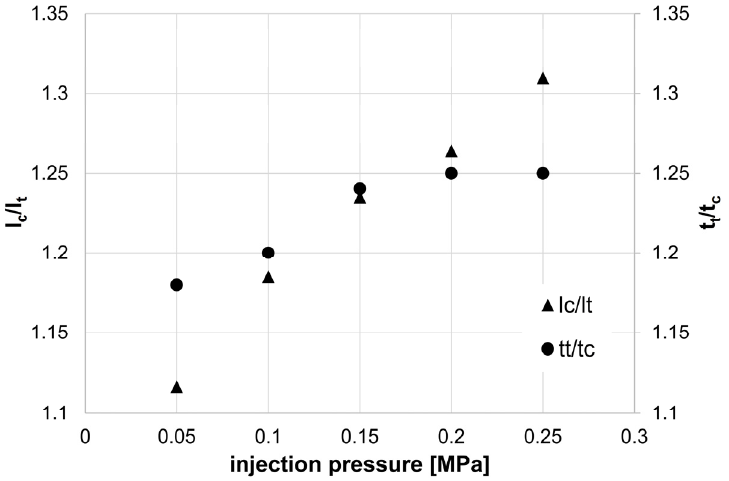
Figure 11. Comparison of the measured length ratios at 60 mm distance from the sprue with the calculated time ratios according to Equation (6).